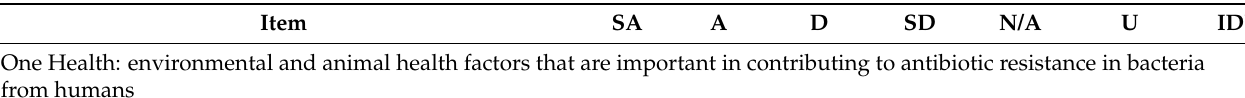
Table 5. Perceived knowledge, opportunity and motivation to prescribe